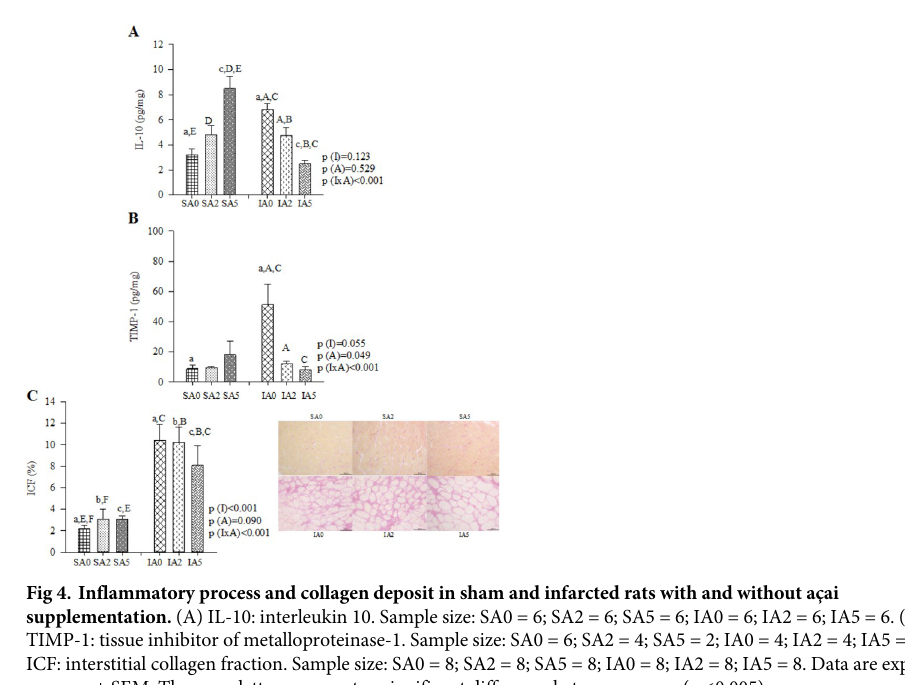
S1 Table. Dose-dependent effects of different doses of ac¸ai supplementation. (DOCX)